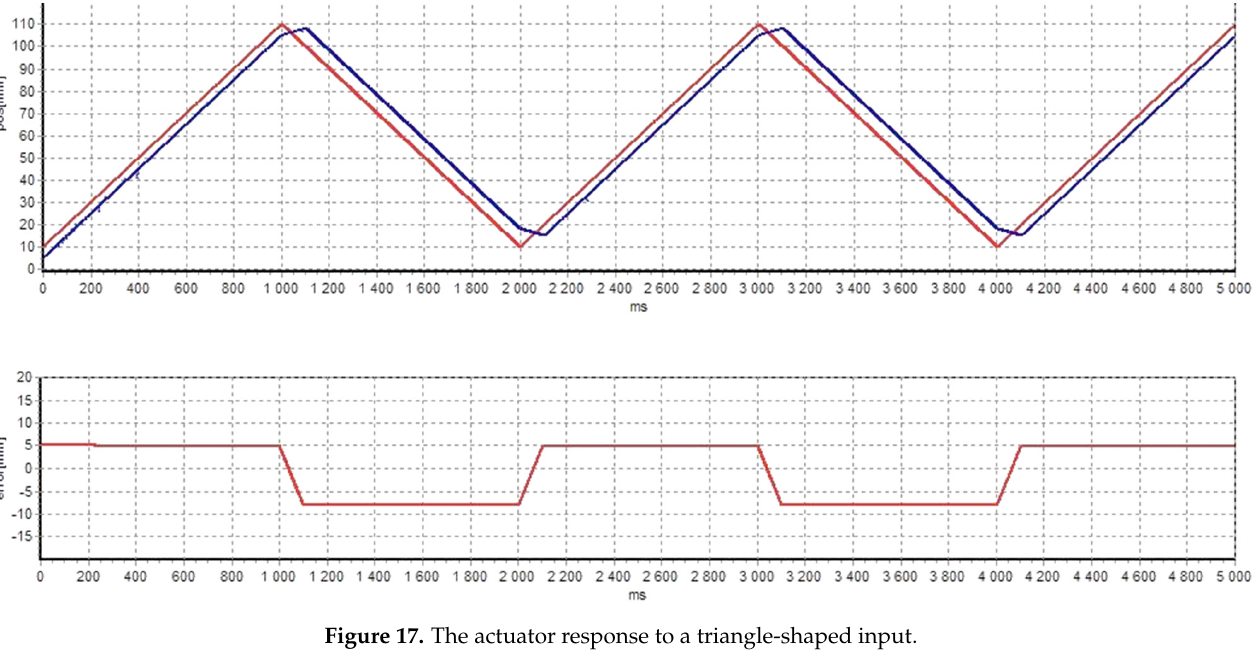
Figure 16. The actuator response to the step input.